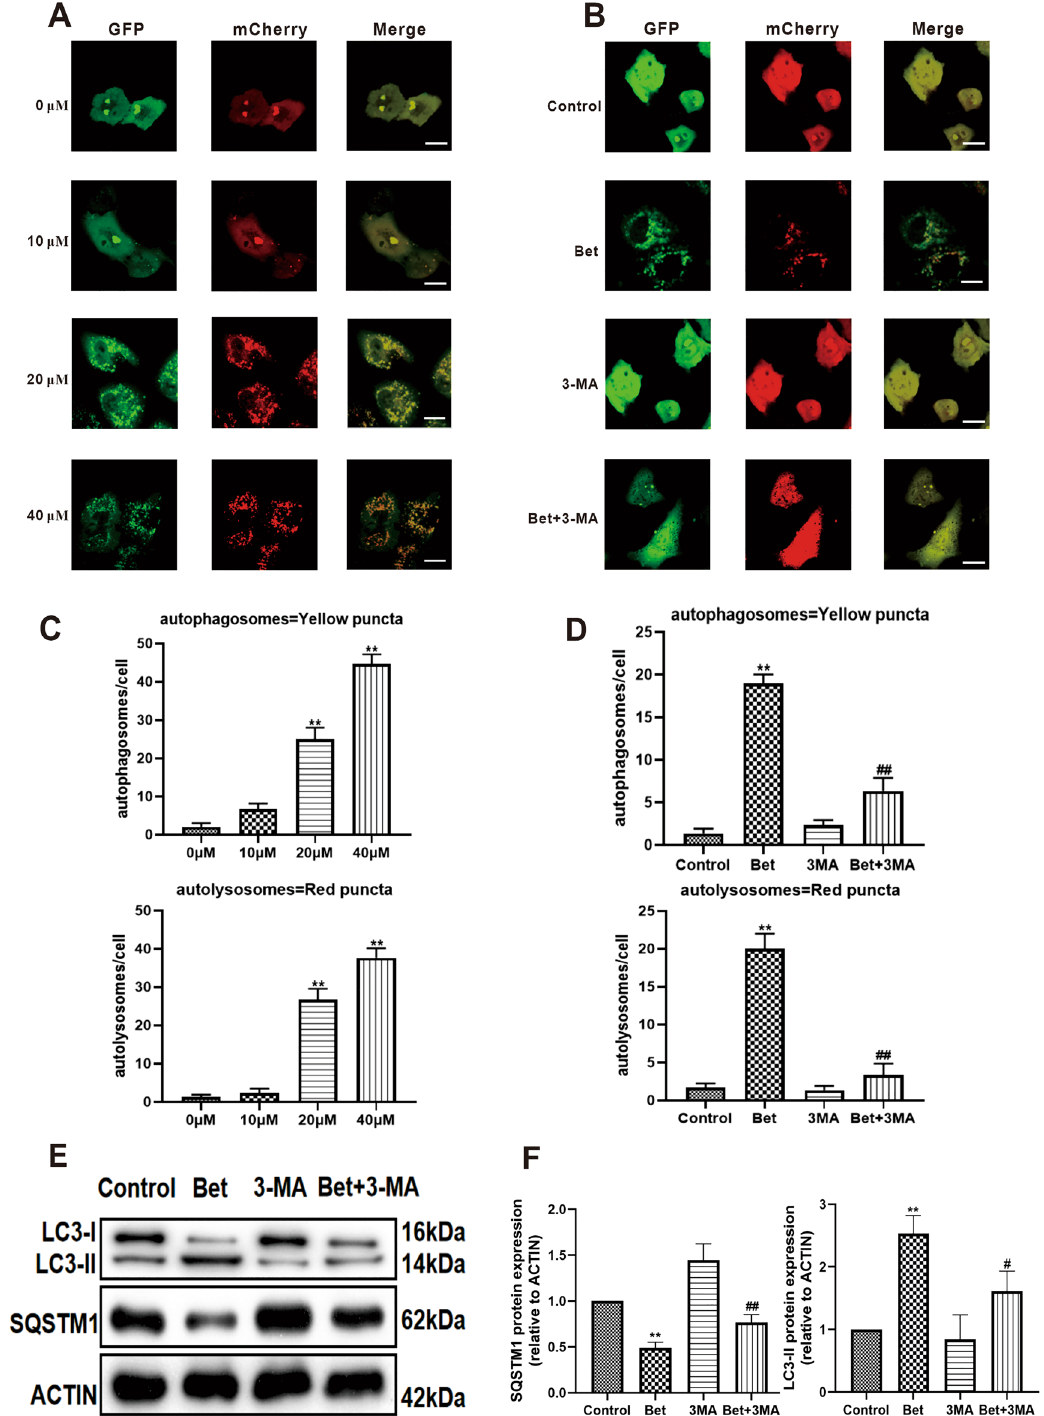
Figure 4. Betulinaldehyde promoted the autophagy flux in A549 cells. ( A ) A549 cells were treated with different concentrations of betulinaldehyde for 24 h before the autophagy flux was analyzed via a confocal laser scanning microscope using mCherry-GFP-LC3B. ( B ) 3-MA was also used to determine the effects of 20-μM betulinaldehyde on the autophagy flux in A549 cells. ( C , D ) Quantification of LC3B positive autolysomomes or autophagosomes in A549/mCherry-GFP-LC3B cells. (E) Expressions of SQSTM1 and LC3-II were tested at the protein level by western blotting. The statistical analyses of the (F) SQSTM1 levels and LC3-II levels are included. Cropped images are displayed, uncropped blots are displayed in Supplementary Fig. 3. The images were collected from different parts of the same gel with same loading amounts. The blot gels shown are representatives of three different experiments (n = 3). All values are expressed as the mean ± SD ( n = 3). Comparisons among multiple groups were performed using one-way analysis of variance. The differences between control and other groups were analyzed using LSD multiple comparison test. * P < 0.05, ** P < 0.01 versus control group, # P < 0.05, ## P < 0.01 versus Bet group (Bet = betulinaldehyde, 3-MA = 3-methyladenine). Scale bar, 20